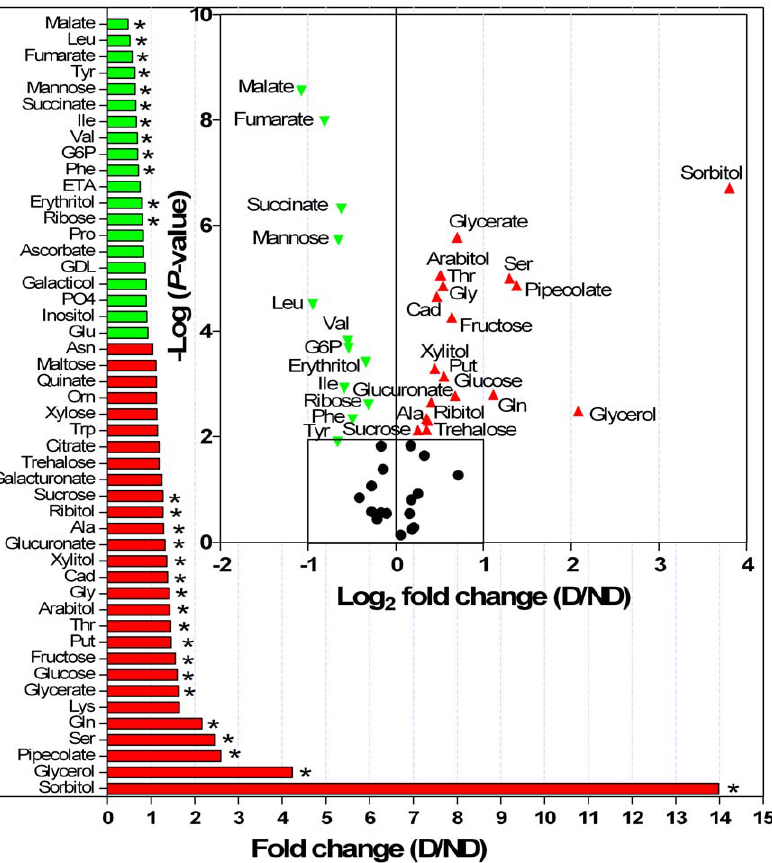
Figure 1. Comparison of metabolite levels in P.volucre mummies. Quotients of mean content of diapausing (D) over nondiapausing (ND) are shown (i.e. fold change). Red and green bars represent increased and reduced metabolite levels in D mummies respectively. Stars indicate significant difference between D and ND treatments ( t -test, P , 0.05). A volcano plot is enclosed within this figure; metabolites are ranked according to their N statistical P -value (y-axis) and their relative abundance ratio between D and ND (log 2 fold change) (x-axis). Off-centred metabolites are those that vary ) for up-regulated, down-regulated and unaffected metabolites in D mummies the most between D and ND phenotypes. Symbols ( m ), ( . ) and ( respectively. Refer to Table 1 for metabolites abbreviation.